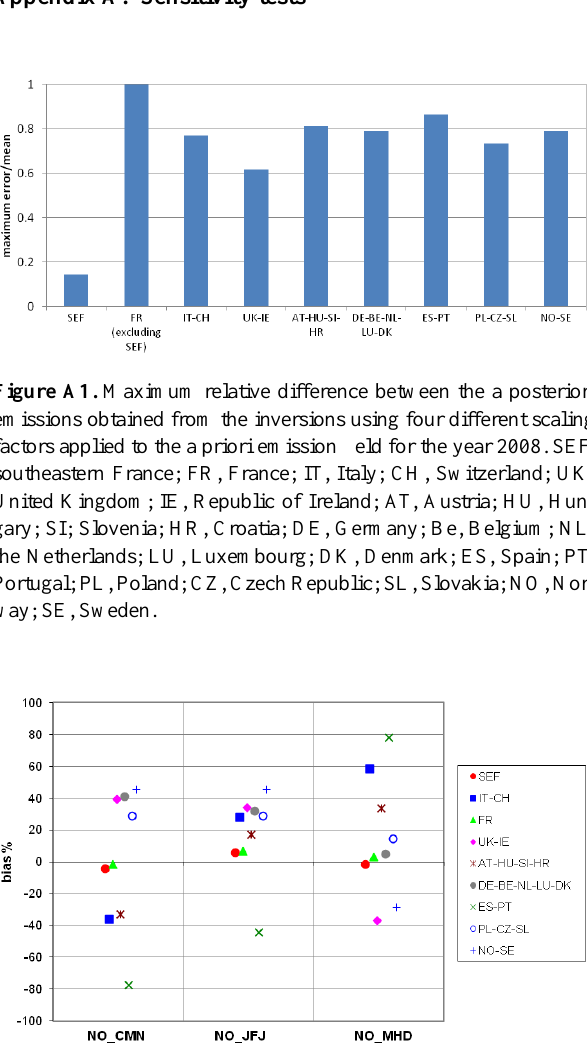
Figure A2. Relative differences in the a posteriori emissions to the reference inversion (in %) when removing one station at a time. Results are shown with CMN (NO_CMN), JFJ (NO_JFJ) and MHD (NO_MHD) removed and for nine different regions.